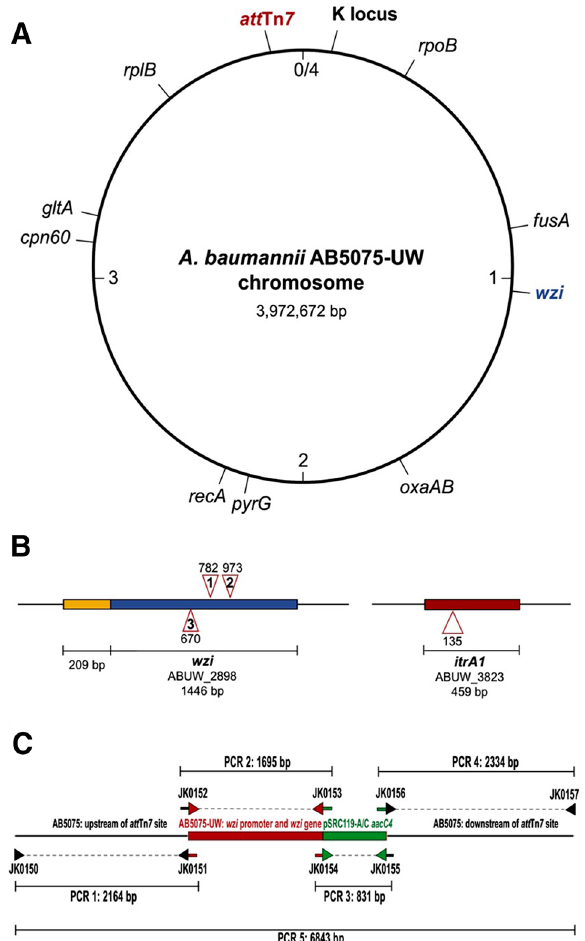
Figure 1. ( A ) Representation of the A. baumannii AB5075-UW chromosome showing location of wzi gene (blue) in relation to the K locus and att Tn 7 site (red). Institut Pasteur MLST alleles and the intrinsic oxaAB gene are also shown. ( B ) Genetic location of T26 insertion sites in A. baumannii AB5075-UW transposon library mutants. Genes, locus tags, and sequence lengths are indicated below the gene. Triangles represent insertion sites at listed base positions in gene sequence. Insertions in the forward strand shown above and insertions in reverse orientation shown below. The intergenic region that includes a predicted promoter sequence for wzi (blue) is shown upstream (yellow). ( C ) Composition of the chimeric gene cassette used to complement wzi::T26 mutant strains. Size of amplicons are indicated along with the positions of oligonucleotide primers used for amplification. Oligonucleotide sequences are listed in Supplementary Table